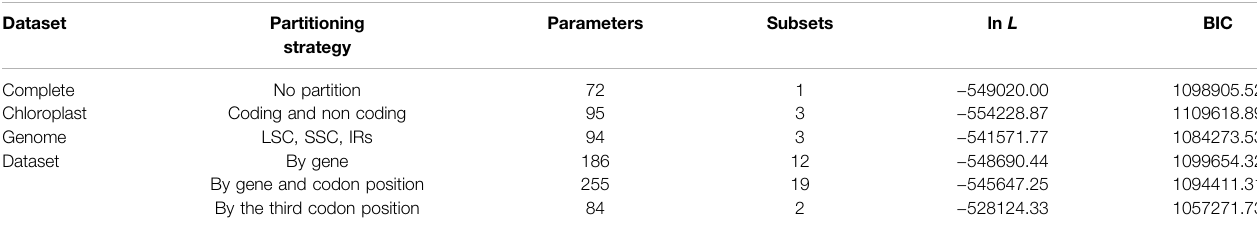
TABLE 3 | Comparison of partitioning strategies used for the complete chloroplast genome